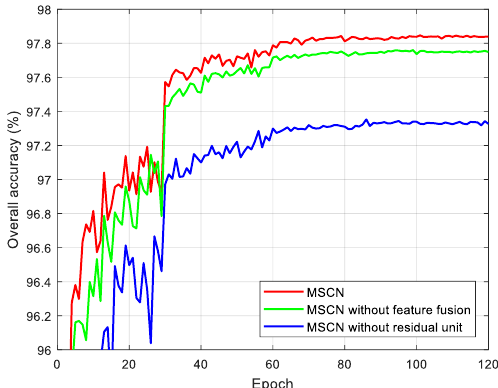
Figure 2. Accuracy curves for MSCN, MSCN without feature fusion, and MSCN without residual